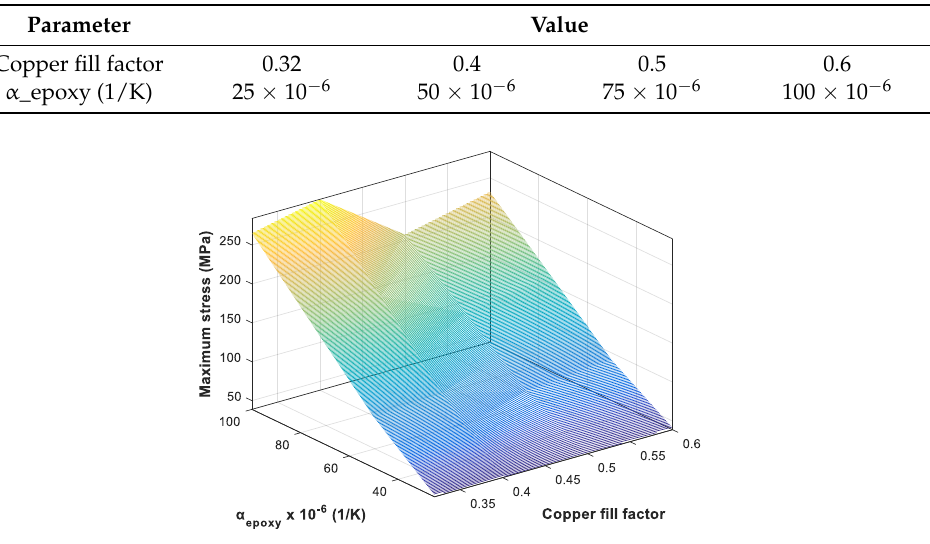
Figure 6. The maximum stress on the copper wire in the middle of the winding, plotted as a function of the copper fill factor and the coefficient of thermal expansion of the epoxy.